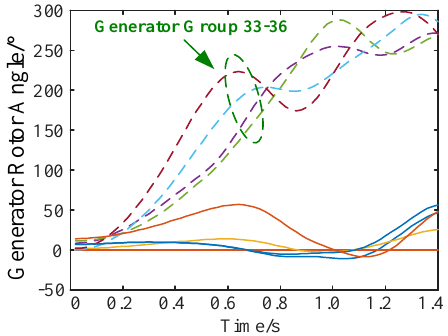
Figure 10. Variation of the generator rotor angles (strategy 2).